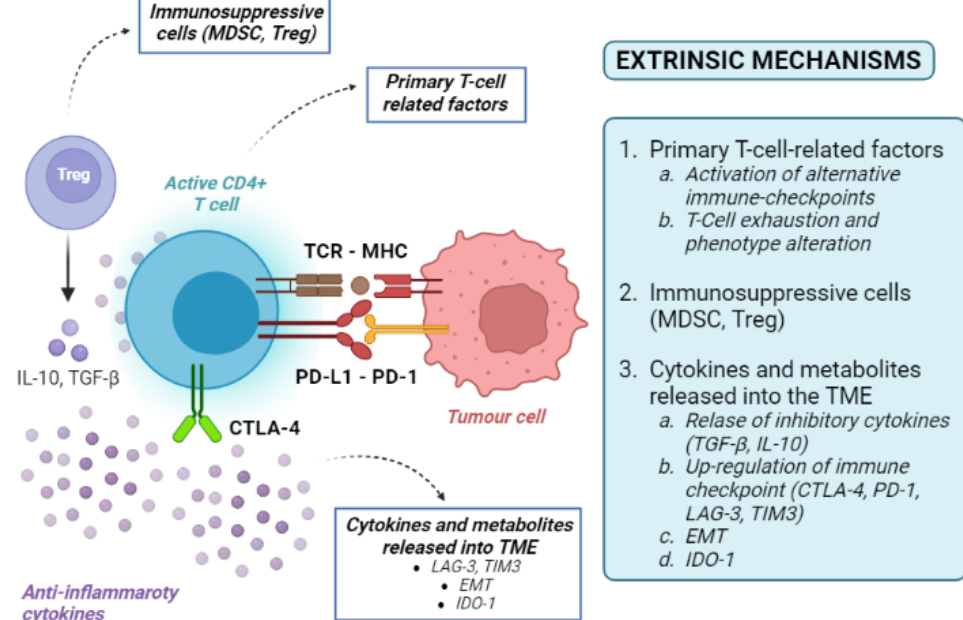
Figure 3. Overview of tumour-extrinsic mechanisms of resistance to immune checkpoint inhibitors.